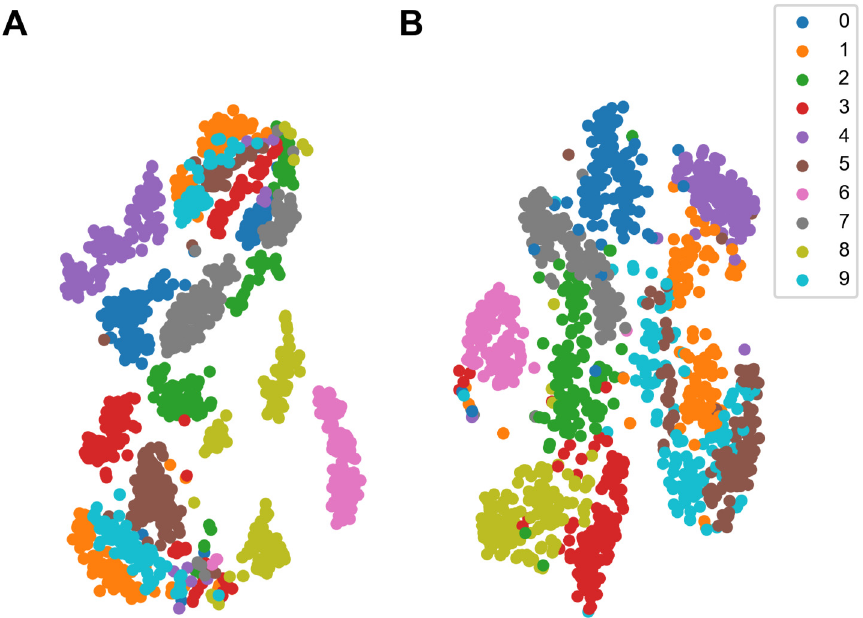
Fig 8. Visualization of MFSC features and SNN output with t-SNE. All samples are color-coded according to their digit classes. (A) The t-SNE visualization of MFSC features. Most digit classes have more than one cluster. (B) The t- SNE visualization of SNN output. The processing of SNN makes the clusters of each digit merged or closer.